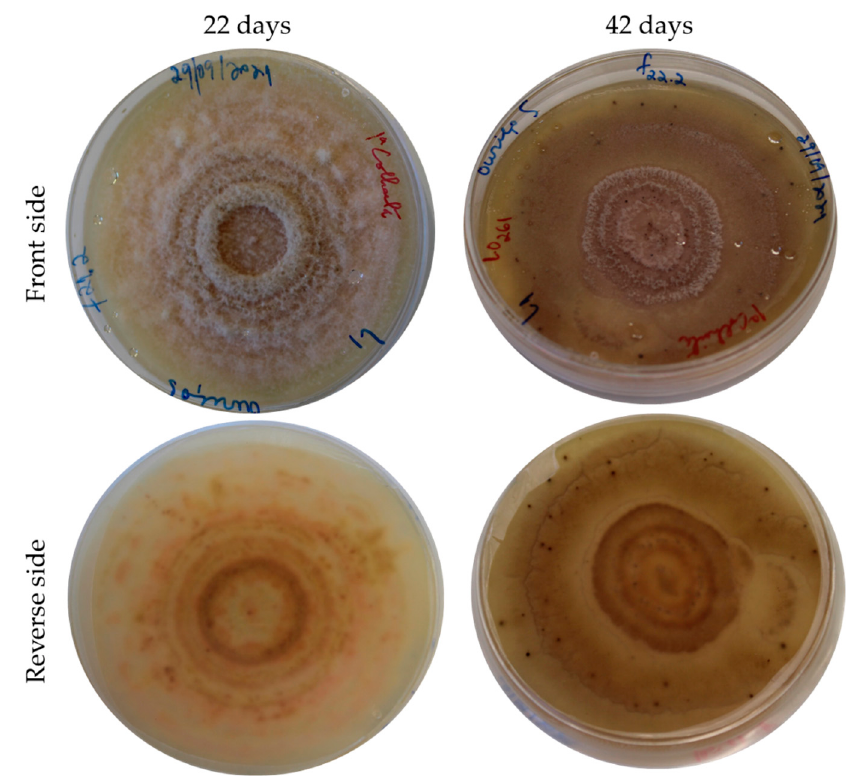
Figure 2. Gnomoniopsis smithogilvyi isolated from the fruit shell after 22 and 42 days of cultivation in a PDA medium.